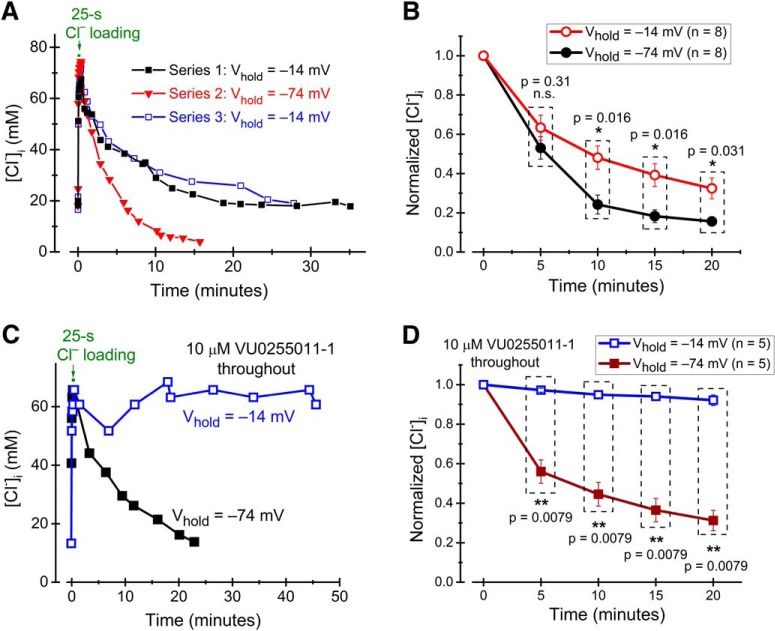
Effect of voltage on [Cl–]i recovery. A, [Cl–]i recovery in an individual cell at two different levels of holding voltage, as indicated, in control solution. Note that [Cl–]i recovers quicker and to a lower concentration at –74 mV compared with at –14 mV. B, Summary of data showing [Cl–]i recovery at –74 and at –14 mV (as in A) in eight neurons. C, [Cl–]i recovery in an individual cell at two different levels of holding voltage, as indicated, in the presence of 10 µM VU0255011-1. D, Summary of data showing [Cl–]i recovery at –74 and at –14 mV in the presence of 10 µM VU0255011-1 (as in C) in five neurons. Probe pulses to estimate [Cl–]i were given at slightly different times during each recovery interval (to keep the membrane potential close to ECl). To compare at similar times, in B and D, interpolation was used for data pairs closest to the time points illustrated, and [Cl–]i was normalized to the maximal concentration during loading.